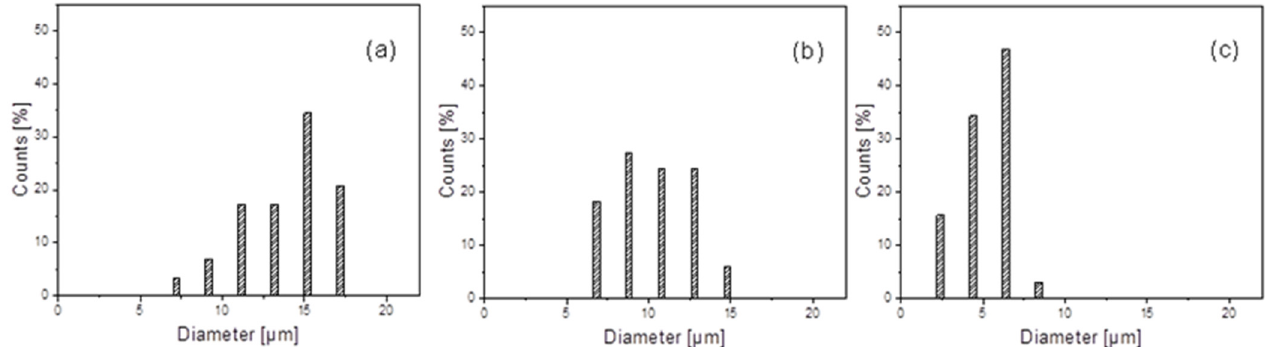
Figure 2. Histograms of the PGA domains diameter in the PLLA-based blends: ( a ) PLLA70/PGA30, ( b ) PLLA80/PGA20, and ( c ) PLLA90/PGA10.